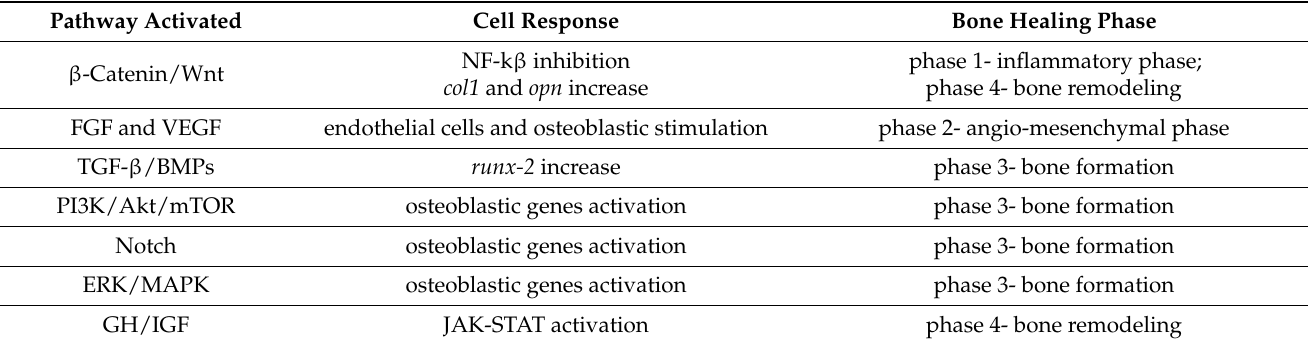
Table 1. Molecular pathways activated by PEMFs